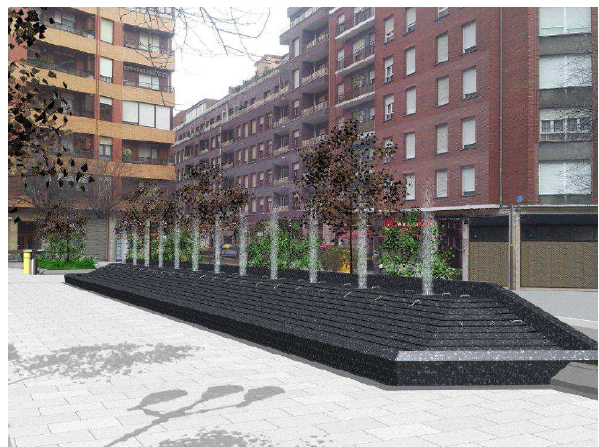
Figure 10: Examples of interventions performed in La Torre square (a noise barrier and fountain to create masking